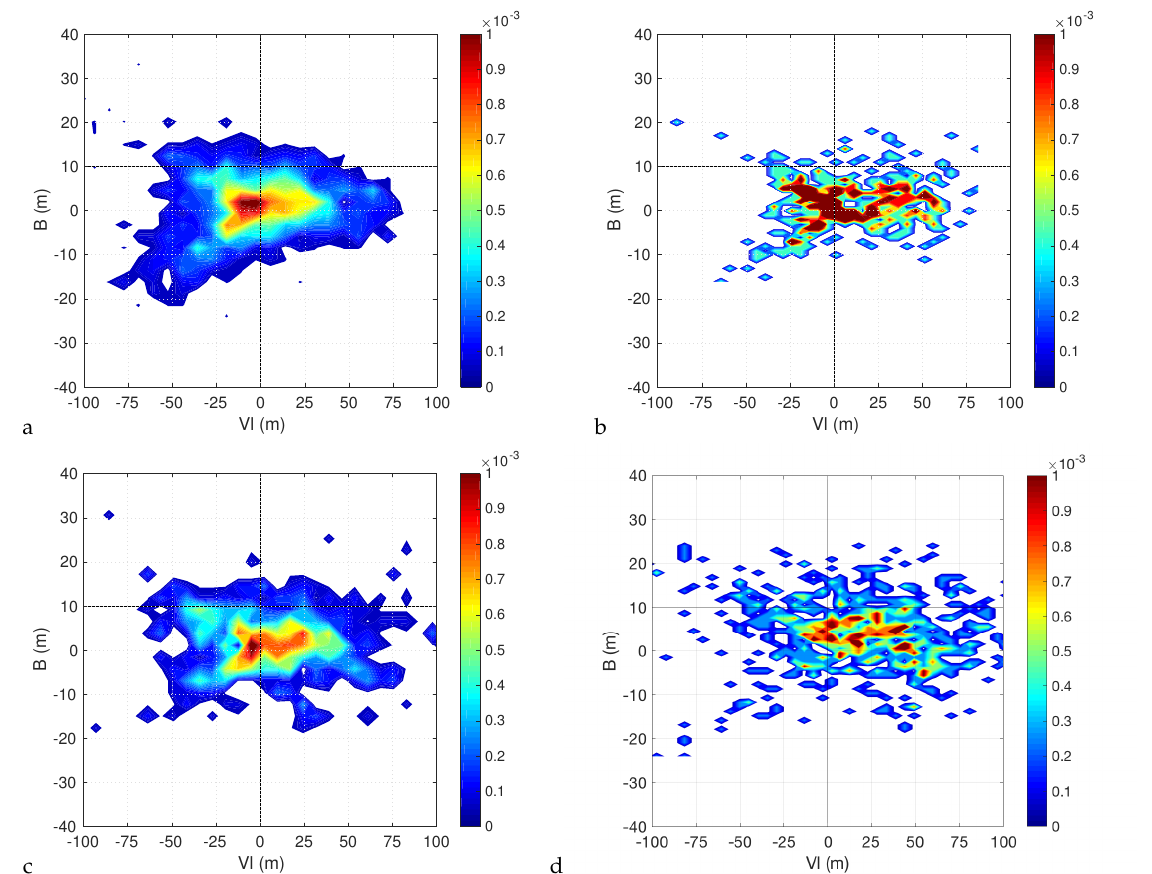
Figure 7. Density of Vl and B Hart parameters for the et04 ( a ), bt11 ( b ), kt11 ( c ) and kw11 ( d ) simulations, for G = 3.21 × 10 − 2 hPa km − 1